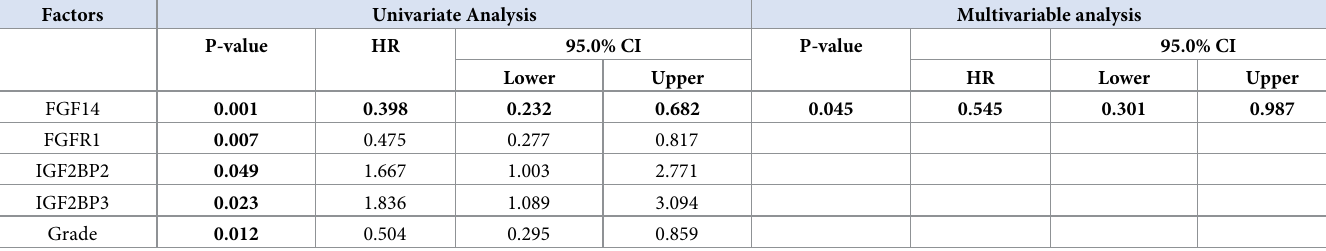
Table 1. Univariate and multivariate analysis of genes for overall survival in cohort 1.